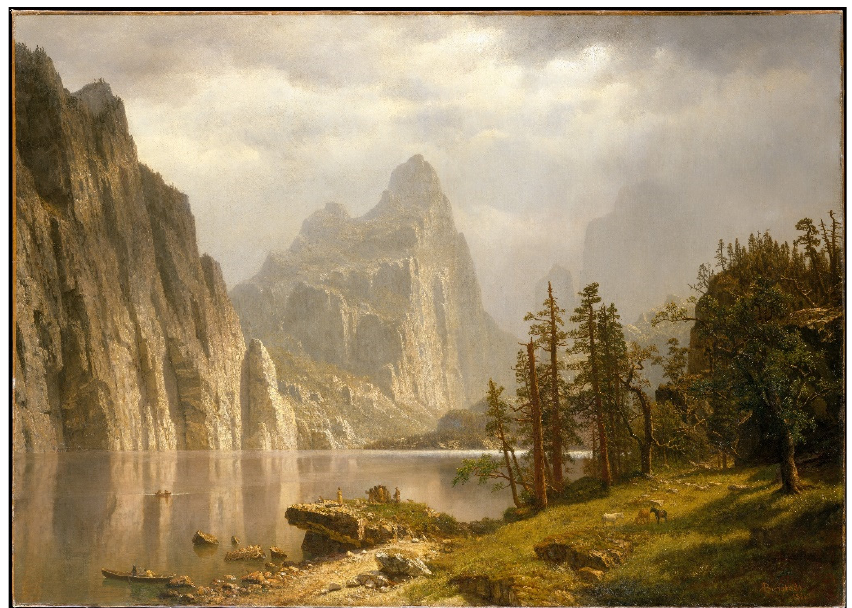
Figure 4. Albert Bierstadt, Merced River, Yosemite Valley , 1866, Oil on canvas, 91.4 × 127 cm, The Metropolitan Museum of Art, Gift of the sons of William Paton, 1909. Accession No: 09.214.1.